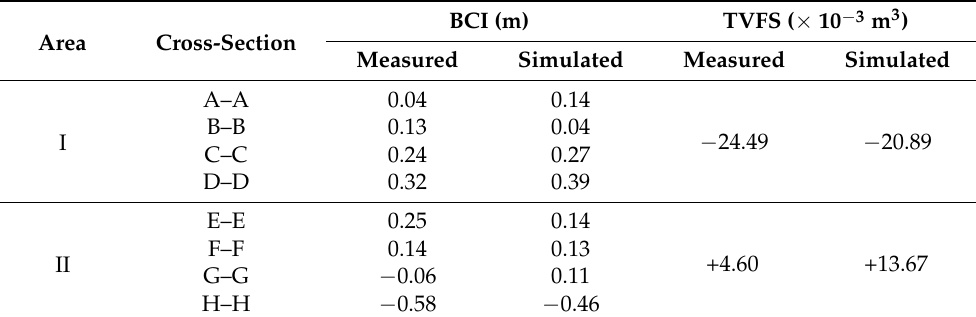
Table 2. Extracted total volume of flushed sediment (TVFS) and bed changes index (BCI) parameter for different areas and cross-sections shown in Figure